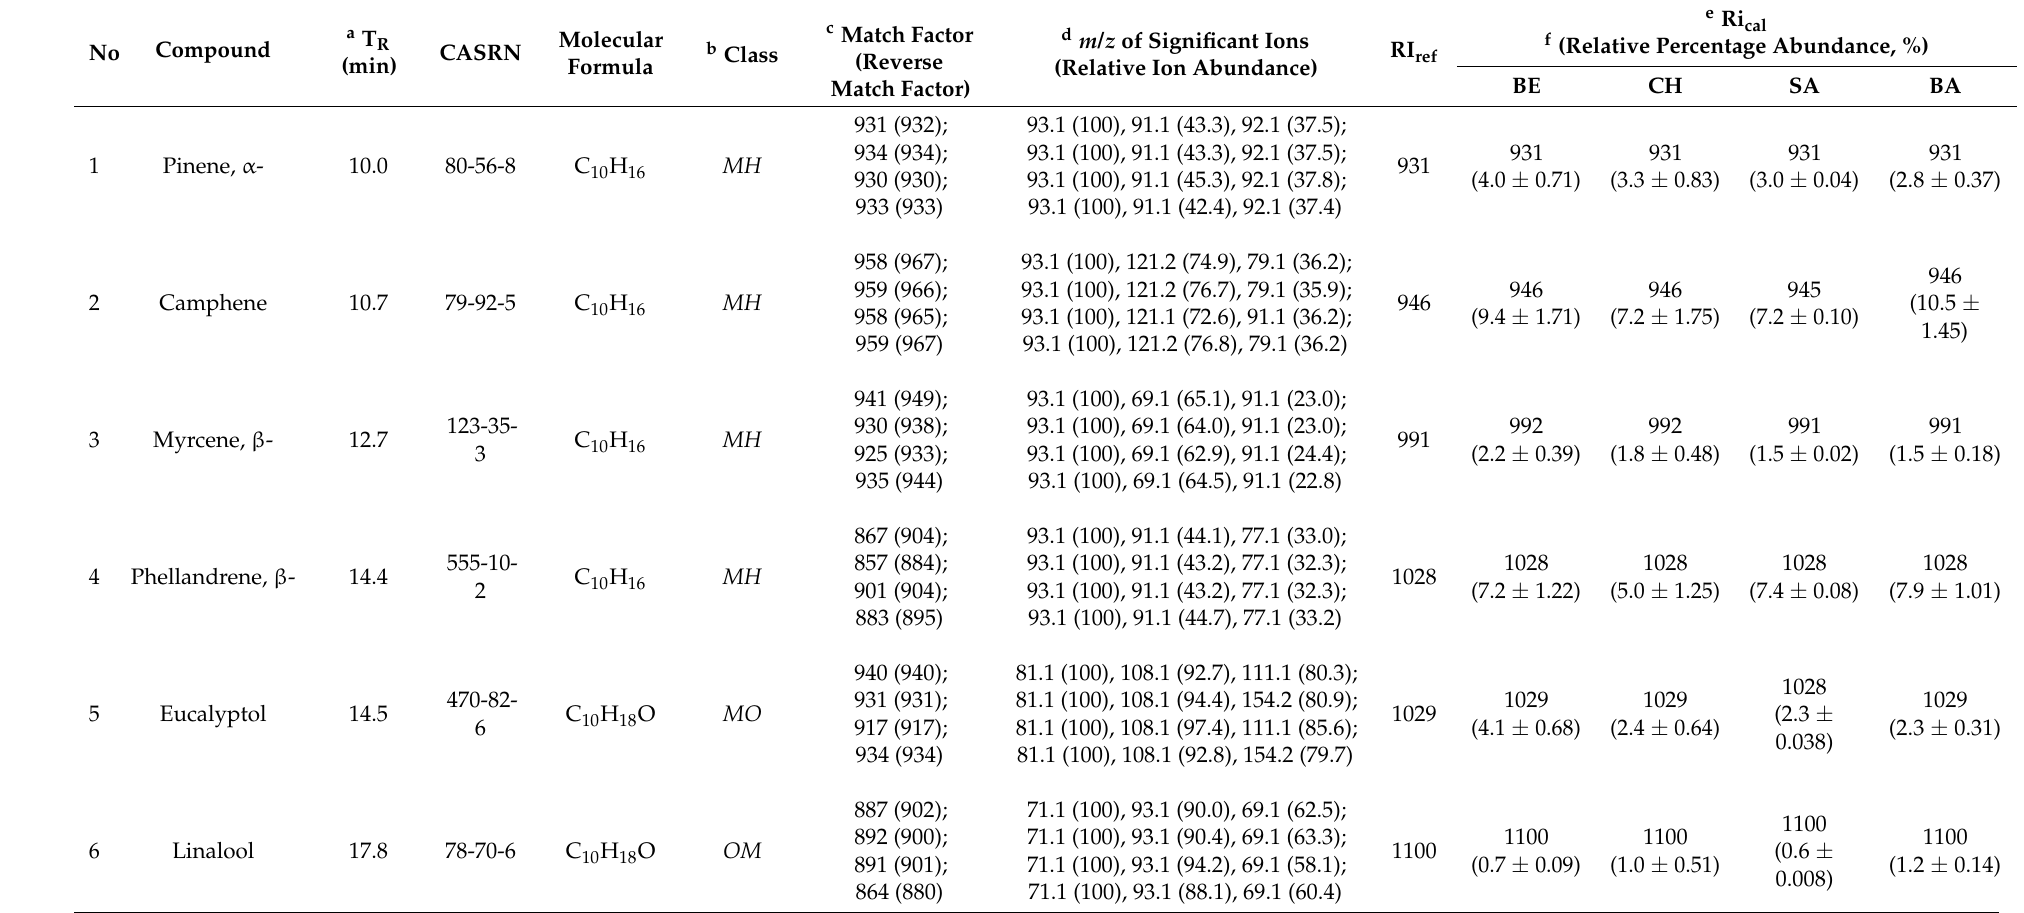
Table 1. Major secondary compounds tentatively identified in different ginger oils using GC − MS. Repeated entries for a given compound correspond to the different ginger